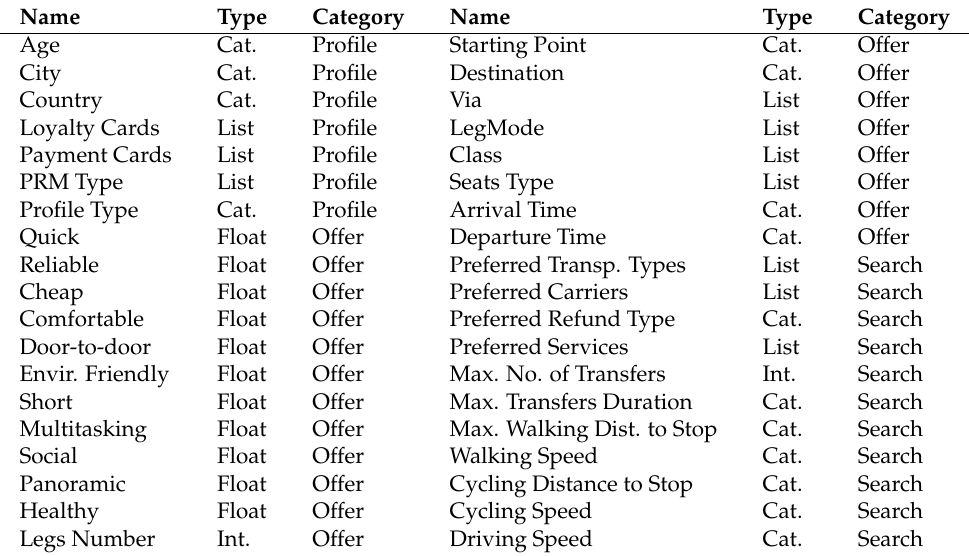
Table 1. Main features used for data generation along with their type and